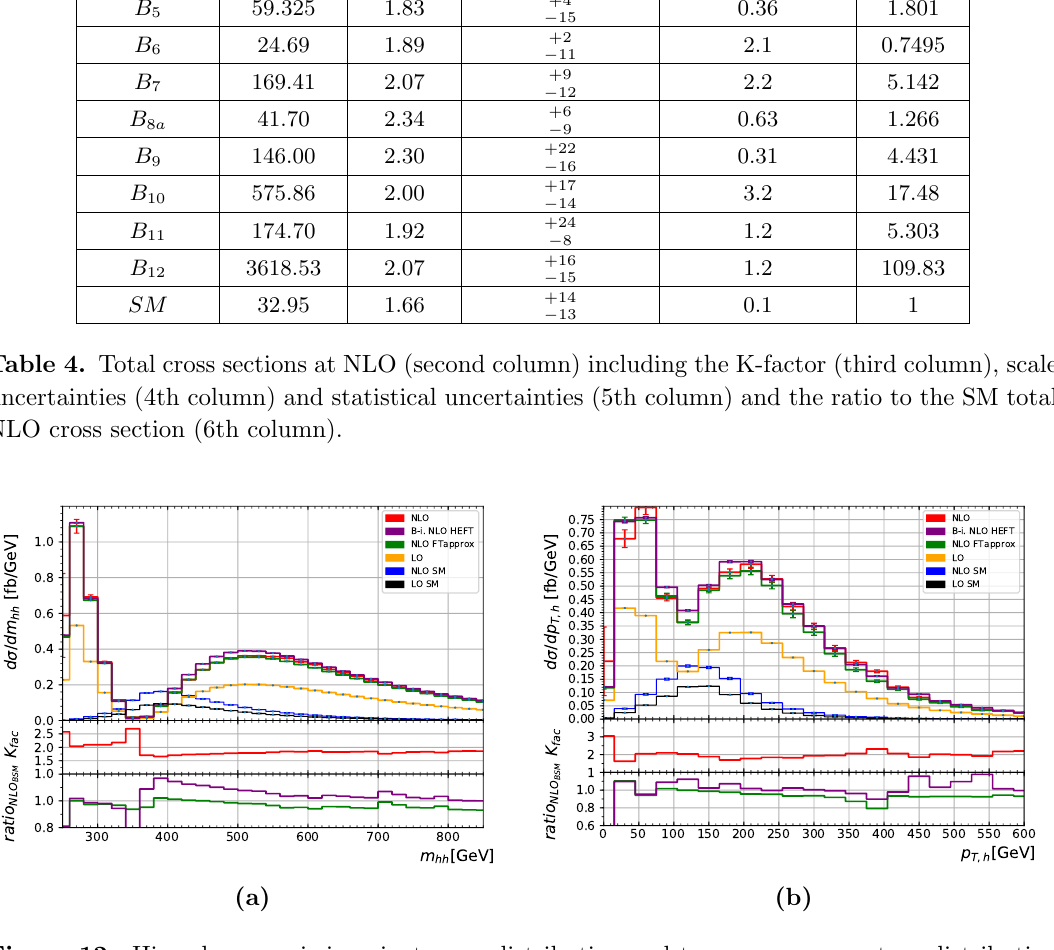
in red, and compare it to the two approximations \Born-improved NLO HEFT" (purple) and FT (green). The leading order (yellow) as well as the SM results are also shown approx (blue NLO, black LO). The lower ratio plot shows the ratio of the two approximate results to the full NLO result. The upper ratio plot shows the di(cid:11)erential BSM K-factor, i.e. NLO /LO , both evaluated with the same PDFs. BSM BSM Figure 12 corresponds to a benchmark point with no Higgs-gluon contact interactions, but an enhanced triple Higgs coupling and a nonzero t (cid:22) thh interaction with c